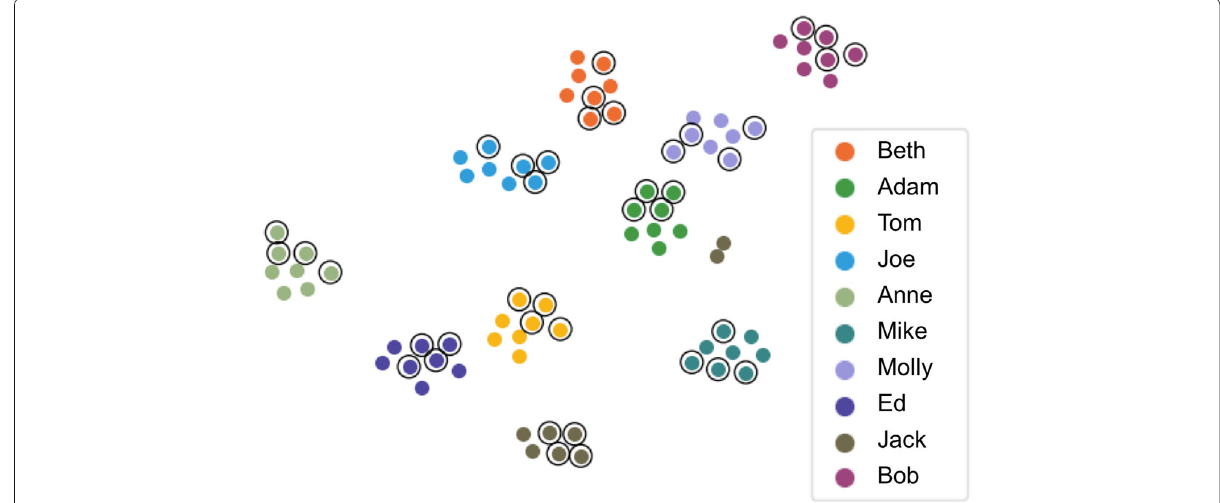
Fig. 7 Results using t-SNE to reduce videos from the qFace dataset from 256 to 2 dimensions. Each individual is represented by a unique colour. Enrolment videos are shown with a border and authentication videos